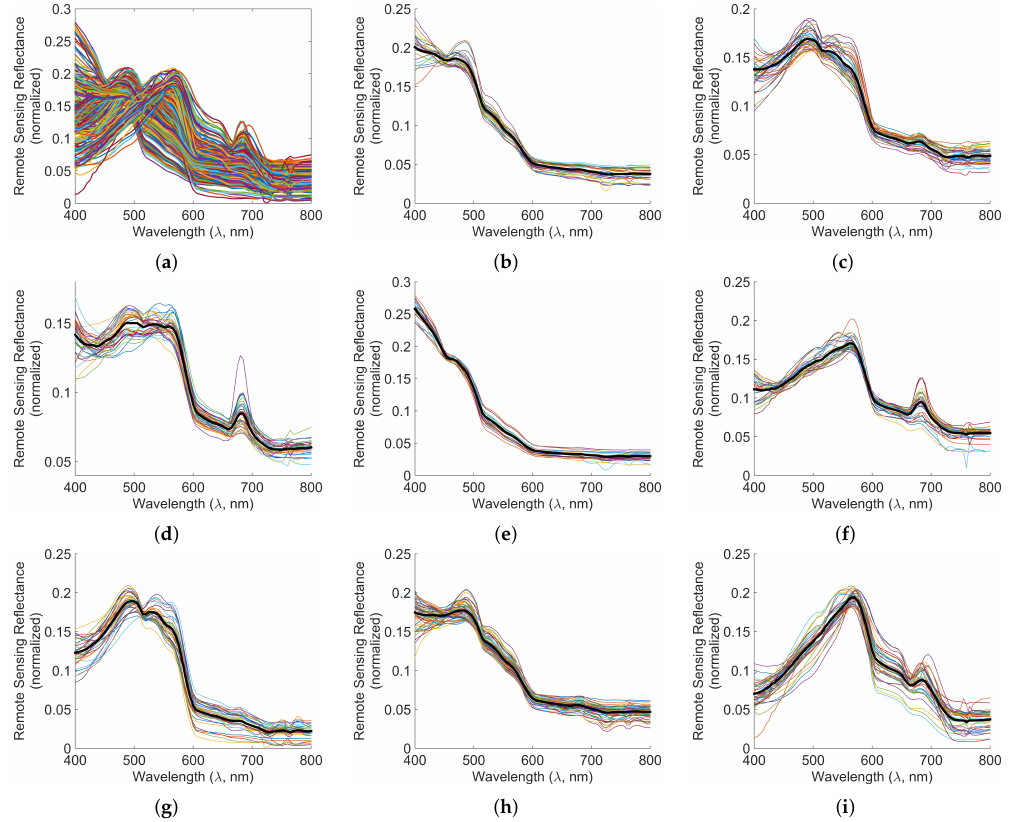
Figure 8. Normalized spectral data and spectral clusters of Dataset 1. The thick black lines in subfigures ( b – i ) show the centroids (cid:126) ρ ◦ of the clusters. ( a ) Normalized reflectances (cid:126) ρ m ; ( b ) Class 1; ( c ) Class 2; ( d ) Class 3; ( e ) Class 4; ( f ) Class 5; ( g ) Class 6; ( h ) Class 7; ( i ) Class